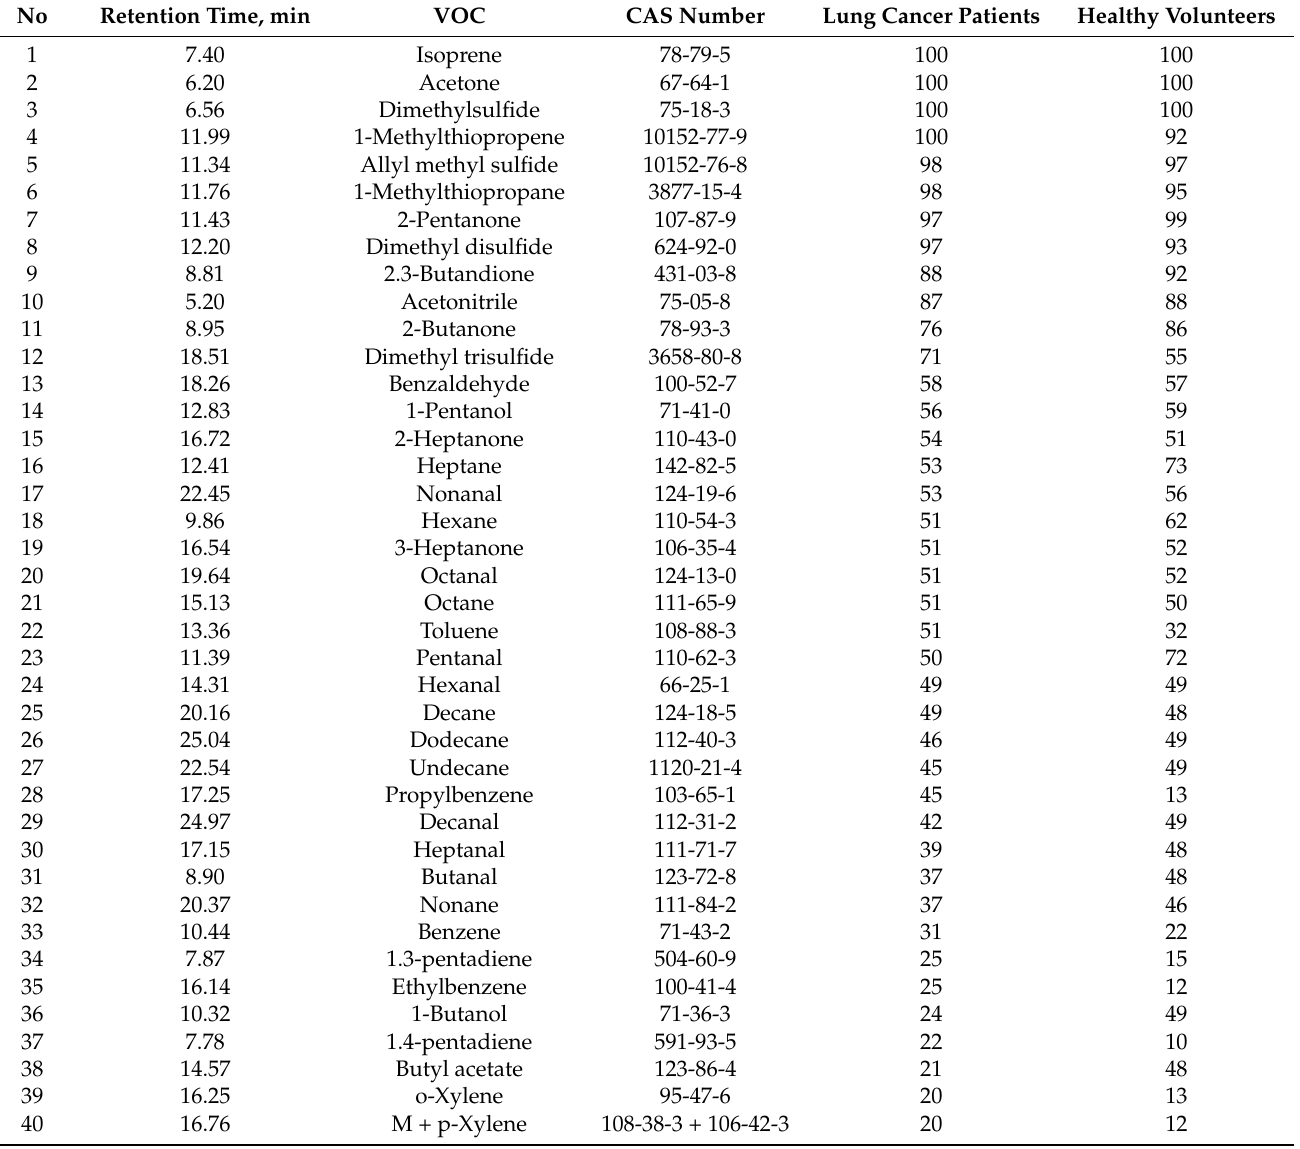
Table 3. Frequency of VOCs occurring in exhaled breath of healthy volunteers and lung cancer patients